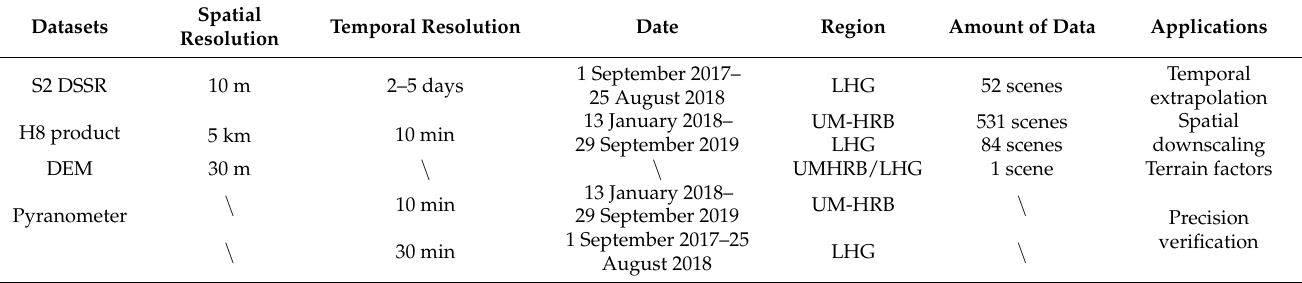
Table 1. Details of the datasets used from the two study areas.